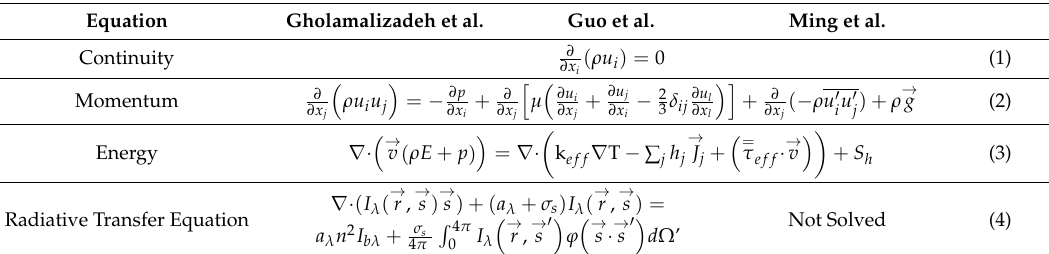
Table 3. Conservation